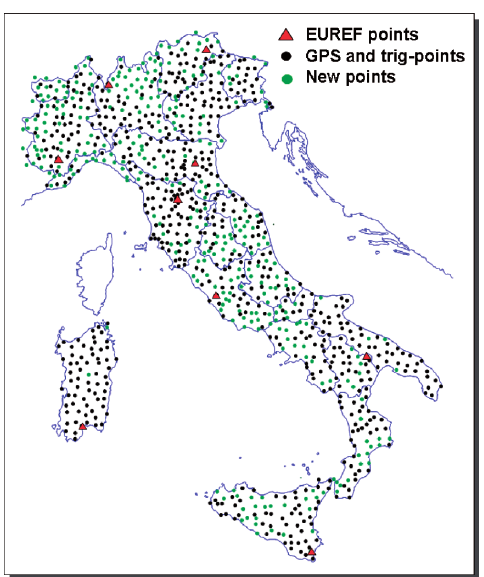
Fig. 1b . The IGM95 (about 1200 benchmarks) (from Surace, 1997,